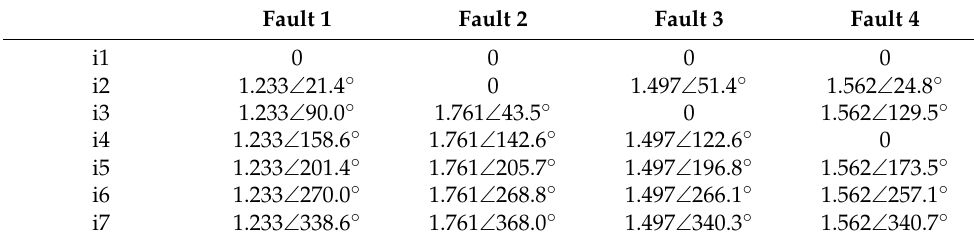
Table 1. Residual phase currents